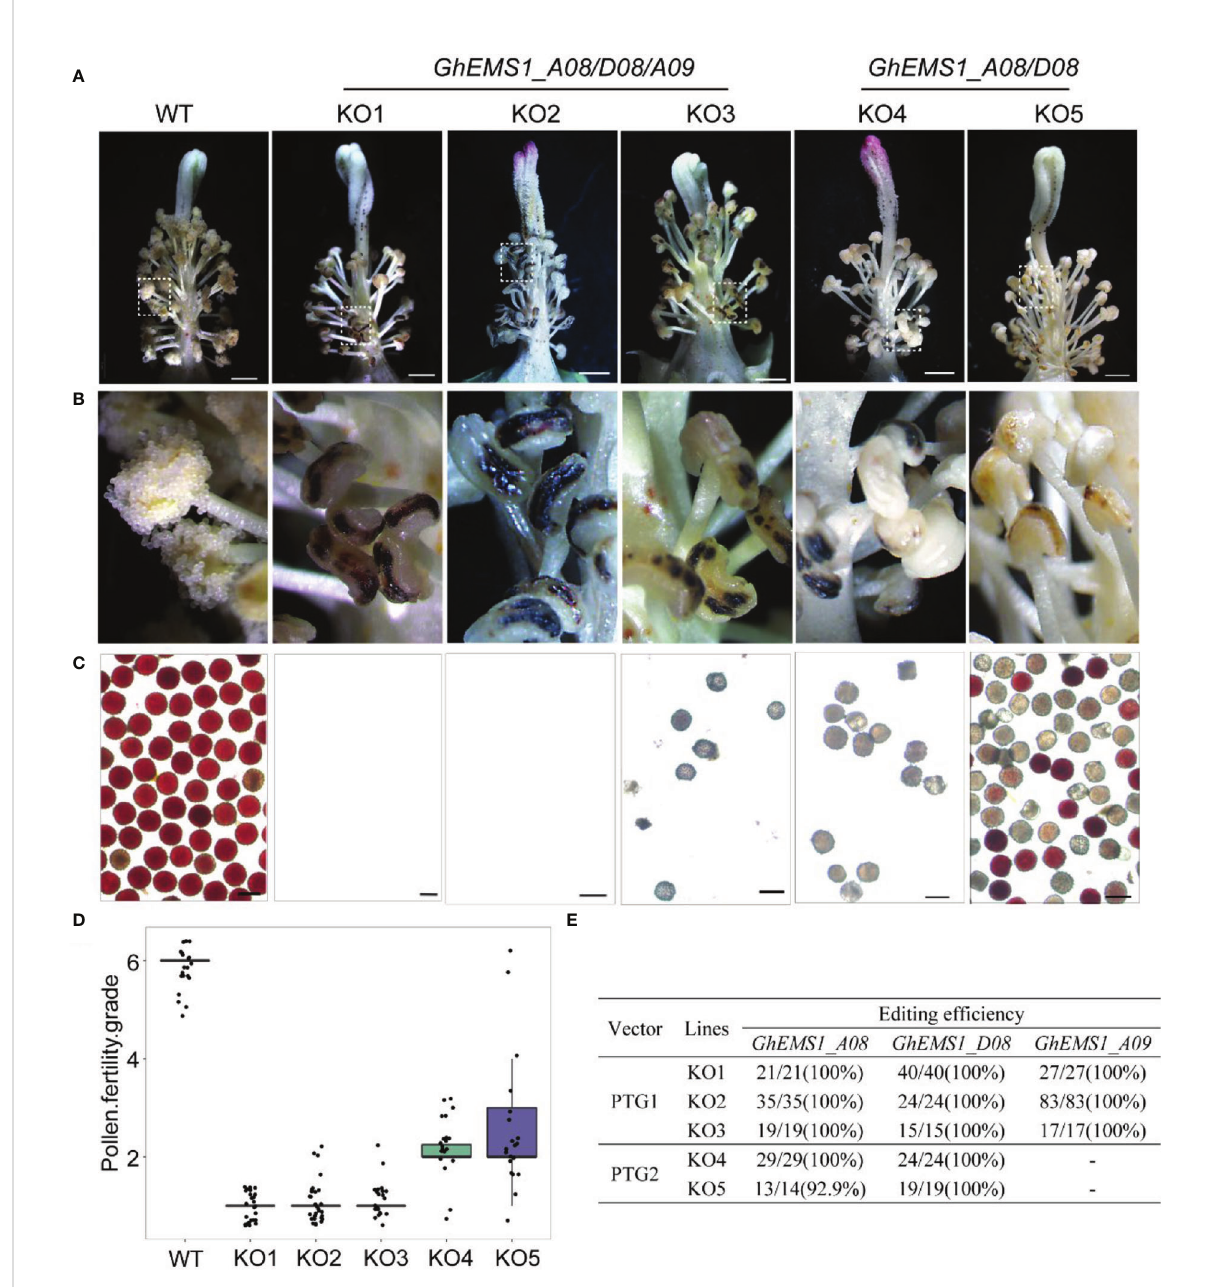
FIGURE 2 Phenotypes of GhEMS1s mutants. (A) The phenotypes of the WT and KO1 - KO5 transgenic lines, three genes Ghir_A08G010860 ( GhEMS_A08 ), Ghir_D08G010810 ( GhEMS_D08 ), and Ghir_A09G018830 ( GhEMS_A09 ) of PTG1 in KO1- KO3 sterile plants. GhEMS_A08 and GhEMS_D08 ( PTG2 ) were knocked out in KO4 and KO5 plants. Scale bars: 2 mm; (B) Partial enlarged view of anther in picture (a); (C) TTC (2,3,5-triphenyl tetrazolium chloride) was used to detect the pollen viability. No pollen was observed in the anthers of KO1 and KO2 plants. Scale bars: 100 µm. (D) Statistics for pollen fertility in the GhEMS1 mutants. During the phenotypic investigation, we divided plant fertility into six levels: Grade 1 indicates that anthers with necrosis-like dark spots and all anthers without pollen; Grade 2 indicates that < 25% of the anthers have a few inactive pollen grains without dehiscence; Grade 3, 4, and 5 indicate that 25%, 50%, and 75% of the anthers spread pollen, respectively; Grade 6 indicates that all anthers dehiscence and release active pollen. The phenotype of every fl ower was recorded, and the fertility of different plants was counted. (E) Analysis of gene editing ef fi ciency in different GhEMS mutant lines by Sanger